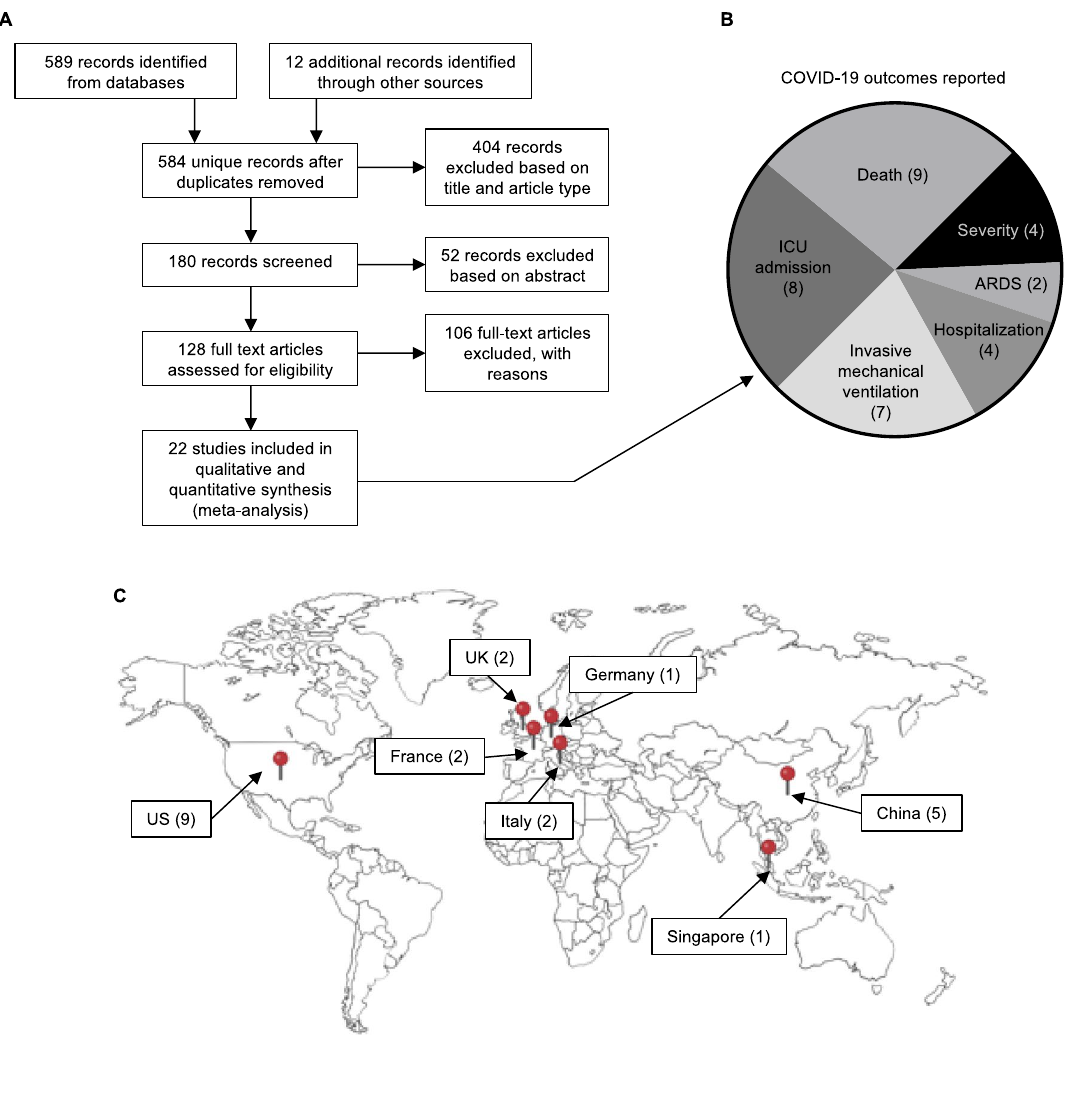
Figure 1. Systematic search strategy and COVID-19 outcomes reported in association with obesity. ( A ) PRISMA Flow Diagram showing the numbers of articles per stage of review, resulting in n = 22 full text articles reporting COVID-19 outcomes stratified on obesity status. ( B ) Six outcomes were reported by the 22 studies included in meta-analysis. The numbers of contributing articles per outcome are in parentheses. Numbers do not add to 22 because some studies report more than one outcome. ( C ) World map showing the locations where the included studies were conducted. The image was generated in BioRender with permission to